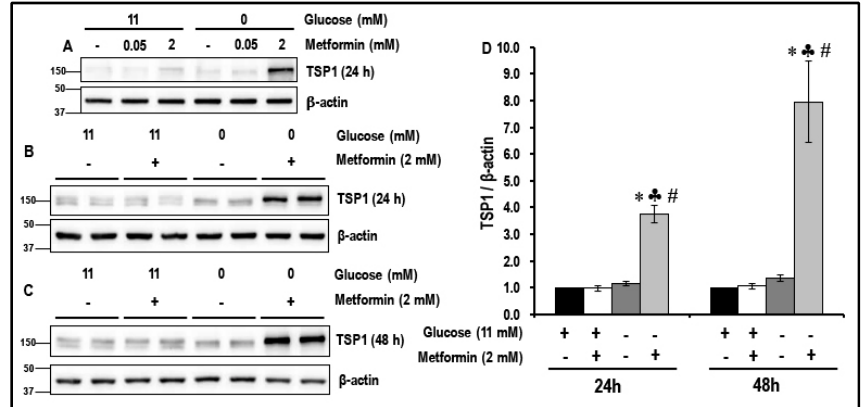
Figure 1 . The levels of anti-angiogenic thrombospondin-1 (TSP1) in metformin-treated normal glucose-exposed and glucose-starved mouse microvascular endothelial cells (MMECs) (24 h and 48 h): Western blot images, ( A ) show the e ff ect of 50 µ M or 2 mM metformin on the levels of TSP1 in normal glucose (11 mM)-exposed and glucose-starved cells, ( B ) and ( C ) show the e ff ect of 2 mM metformin on the levels of TSP1 in normal glucose (11 mM)-exposed and glucose-starved cells after 24 h and 48 h in culture, respectively. Bar graphs ( D ) represent the levels (normalized with b-actin loading controls) of TSP1 in the cells after 24 h and 48 h in culture. * p < 0.05 indicates significance when compared to non-treated controls (11 mM glucose-exposed MMECs), ♣ p < 0.05 indicates significance when compared to 11 mM glucose + 2 mM metformin-treated cells and # p < 0.05 indicates significance when compared to glucose-starved